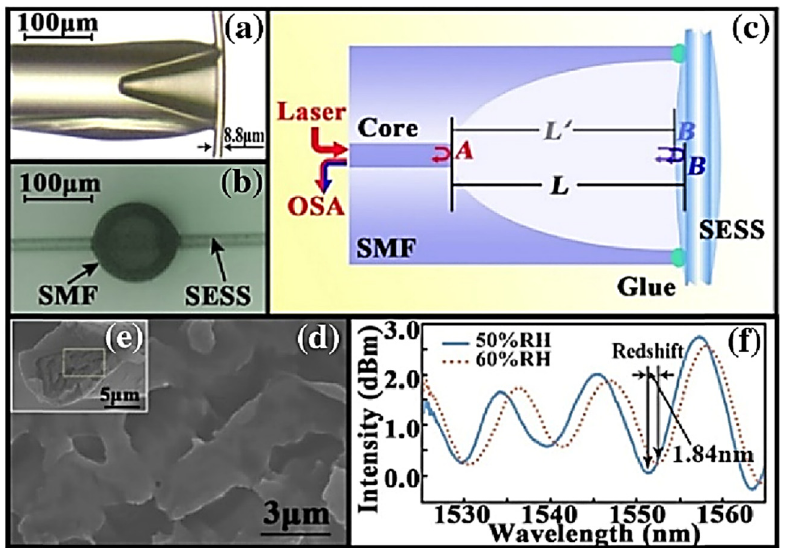
Figure 8: Structure and experimental results of a humidity sensor ( 87 ) . ( a ) Microscopic image of a SESS - based humidity sensor probe. ( b ) Side view of a SESS - based humidity sensing probe. ( c ) Front view of a SESS - based humidity sensing probe. ( d ) Scanning electron microscope ( SEM ) photograph of the SESS pro fi le ( partially enlarged ) . ( e ) SEM photograph of the SESS data. ( f ) The experimental result of the redshift of interference spectrum from 50% to 60% RH at 1.8° nm at 35°C. Copyright 2019, OSA Publishing.